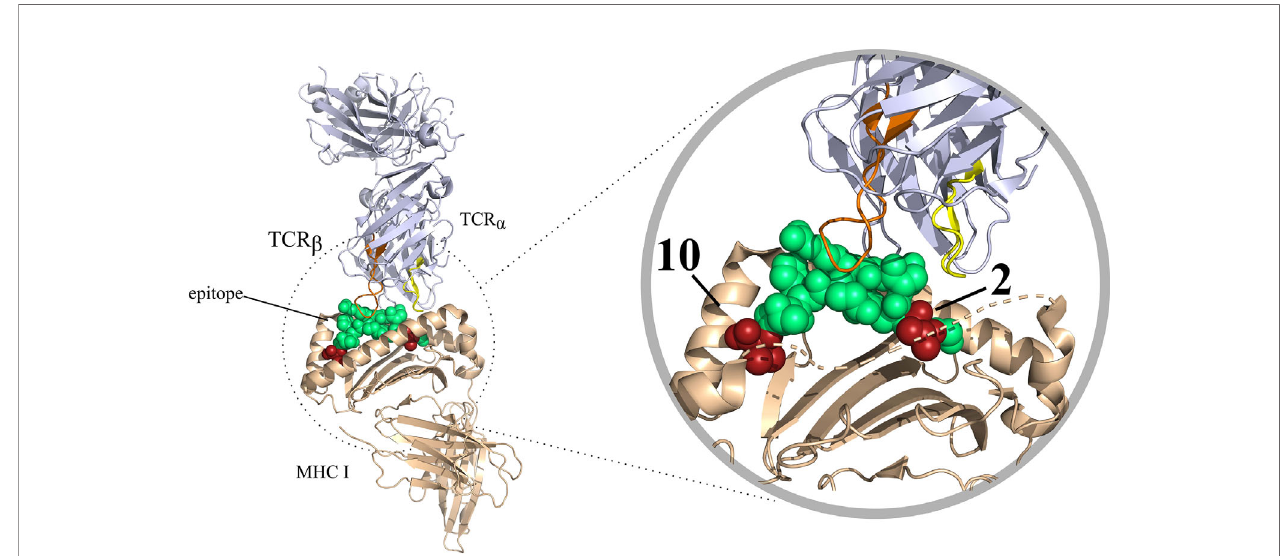
FIGURE 2 | T-cell interaction with a pMHC complex rendered in PyMOL (PDB code: 6TRO). Here MHC I is shown as colored in beige. The TCR is colored blue white. The CDR3 variable regions of the T-cell have been colored in different colors, these are as follows: CDR3 a colored in yellow, CDR3 b colored in orange. The bound peptide is colored in green, with the anchor residues are colored in